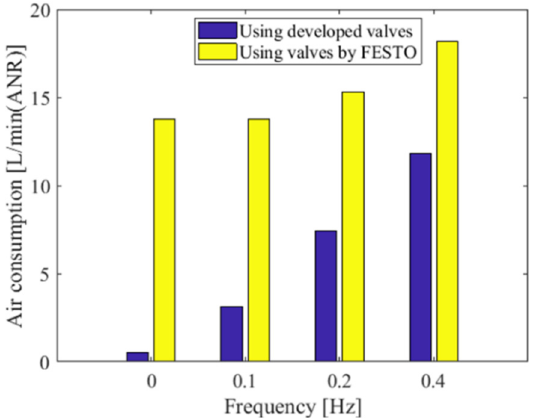
Figure 22. Air Figure 22. Air consumption.